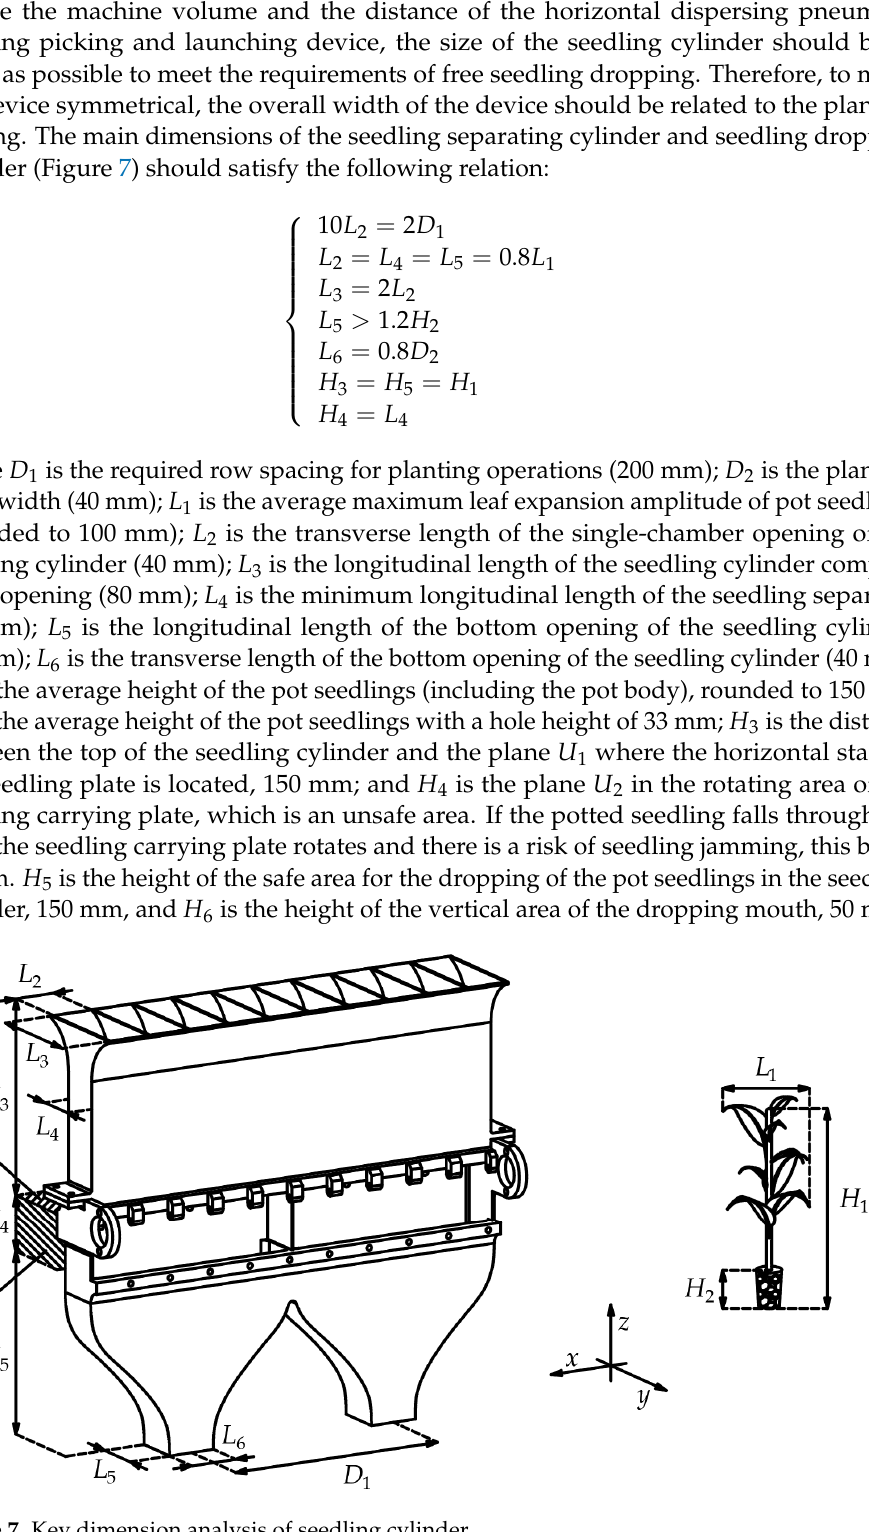
Figure 7. Key dimension analysis of seedling cylinder.